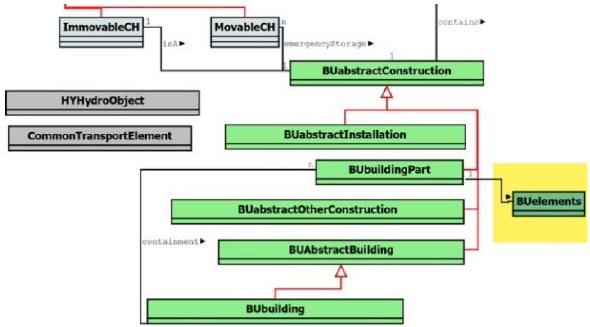
Figure 11. Simplified schema of proposed EID CM extension.